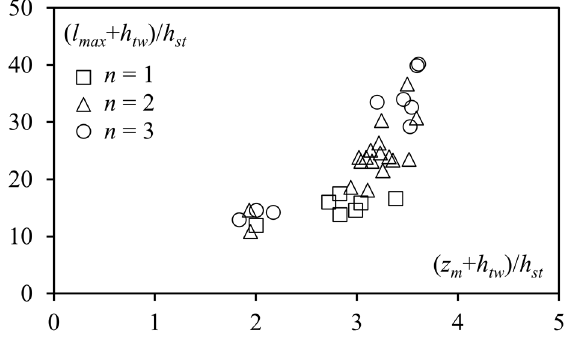
Figure 12. ( l max + h tw )/ h st vs. ( z m + h tw )/ h st . Data point are distinguished according to the different values of n .